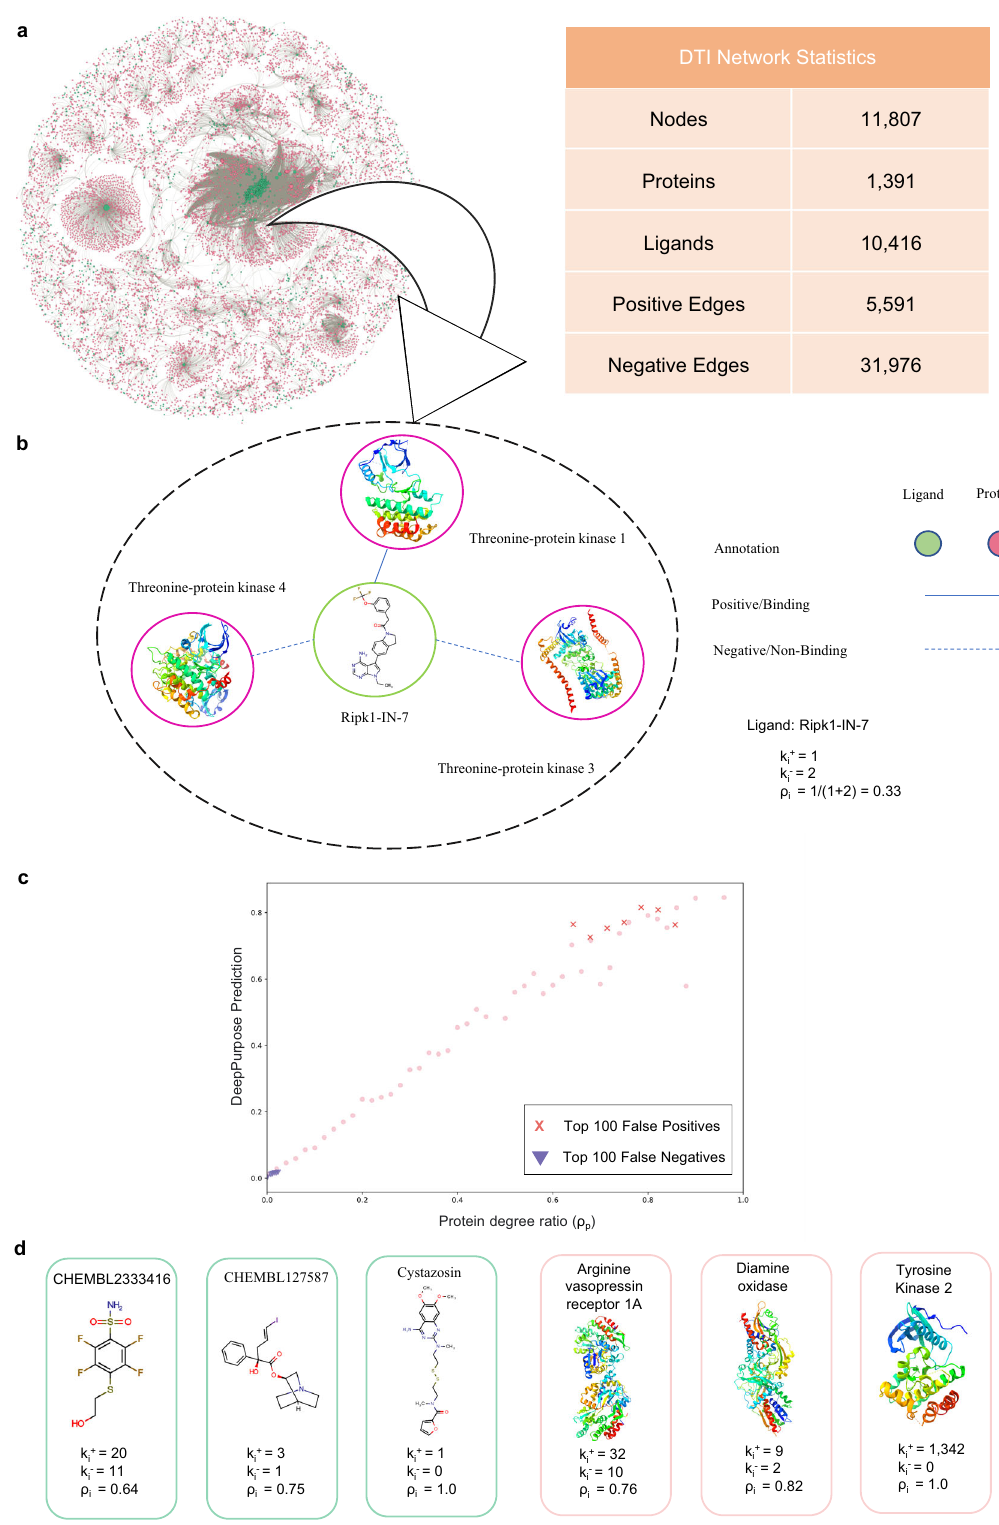
Fig. 2 | Drug-Target Interaction Network. a The drug-target interaction network used to train the DeepPurpose models consists of 10,416 ligands and 1391 protein targets. Ligands and proteins are represented by green and pink nodes, respec- tively. b Network neighborhood of the ligand Ripk1-IN-7. Solid links represent positiveorbindingannotations,whiledashedlinksrefertonegativeornon-binding annotations. Ripk1-IN-7 has one positive and two negative annotations in the training data, implying a degree ratio ρ of 0.33. c Protein degree ratios { ρ p } and